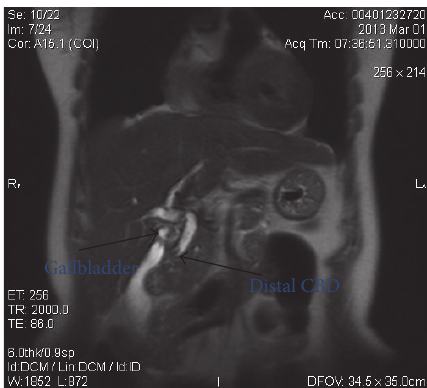
Figure 1: MRI: coronal section shows gallstones and the pointed filling failure in the distal common bile duct.